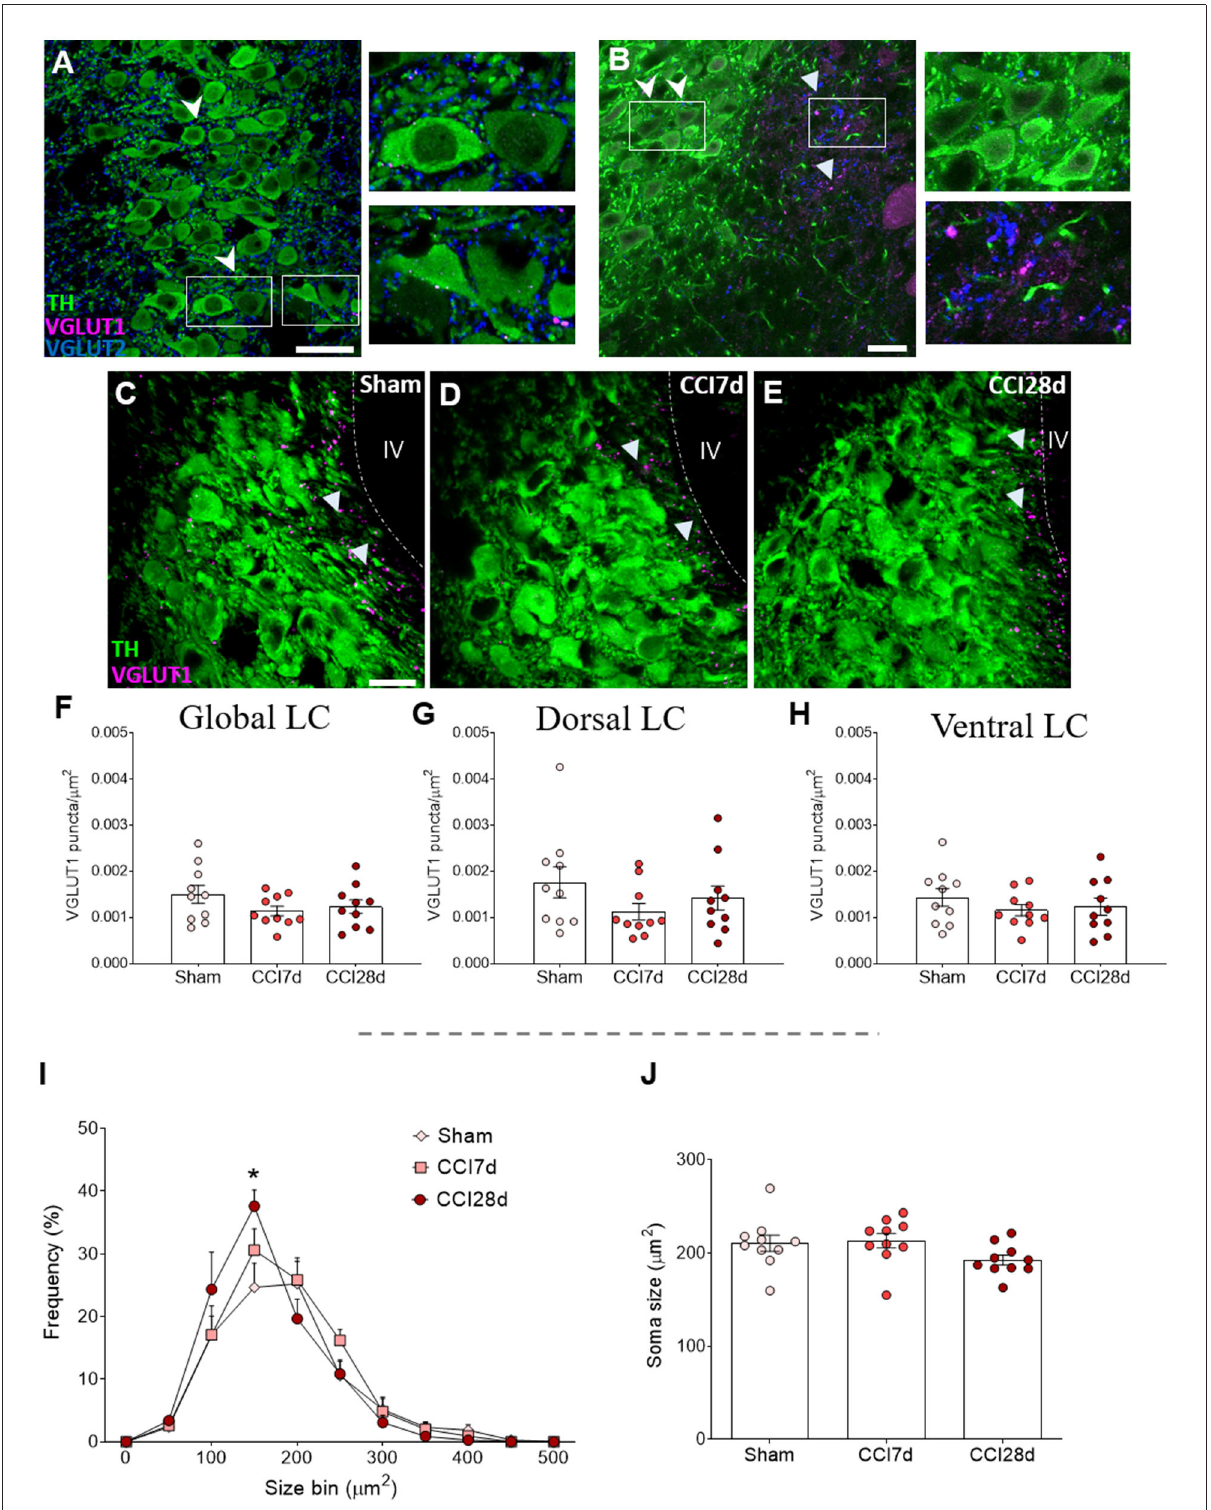
FIGURE2 Study of VGLUT1 expression in the LC of neuropathic pain rats. (A,B) Localization of the vesicular glutamate transporter 1 (VGLUT1) and vesicular transporter 2 (VGLUT2) in the LC region. The arrowheads point to VGLUT2 + puncta in both the pericoerulear and perisomatic area (TH green; VGLUT1 magenta; VGLUT2 blue: scale bar, 20 µ m). The triangles point to VGLUT1 + puncta mainly in the pericoerulear area. (C–E)